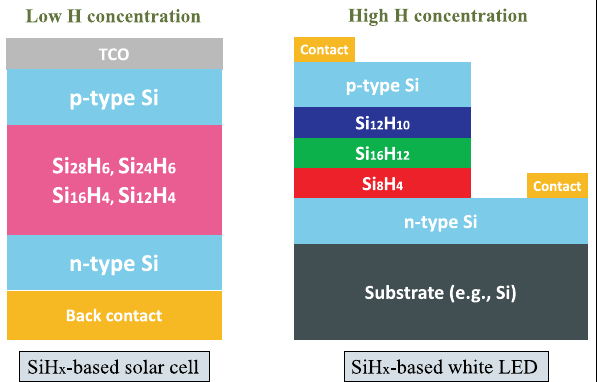
FIG. 10. Summary figure. Unusual optoelectronic properties of hydrogenated bilayer silicon: From solar absorber (low H concentration) to light-emitting diode (high H concentration)